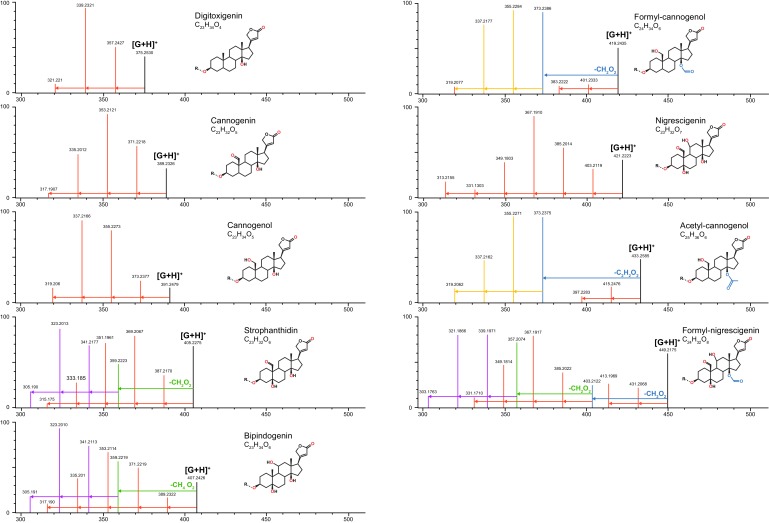
Characteristic MS fragmentation patterns of cardenolide genins used for putative identification of compounds.Patterns are primarily generated by in-source fragmentation of compounds and are visible at standard MS conditions, but fragments are more abundant under MSE (high energy fragmentation) conditions. Height of vertical lines indicates relative ion intensities (in MSE) for representative compounds quantified in Erysimum spp. The mass and intensity of the intact genin ([G+H]+) in each panel is indicated by a vertical black line. Genin fragments are colored to highlight fragmentation series: red vertical lines linked by arrows represent serial losses of water molecules (−18.01 m/z per molecule), corresponding to the number of exposed OH groups of that molecule (red symbols). Acetyl and formyl groups are lost as intact units (blue lines/arrows and corresponding symbols), after which further loss of water molecules occurs (orange lines/arrows). In strophanthidin and bipindogenin, additional larger fragments are lost, perhaps by reconfiguration of the genin molecule (green lines/arrows), and again, further loss of water molecules occurs (purple lines/arrows). Fragmentation patterns for strophanthidin and digitoxigenin were confirmed by commercial standards. For remaining genins, likely identifications and structures were inferred from literature reports.